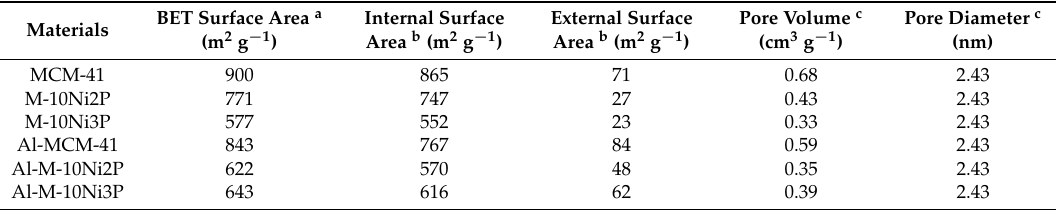
Table 1. Textural properties of the synthesized materials.